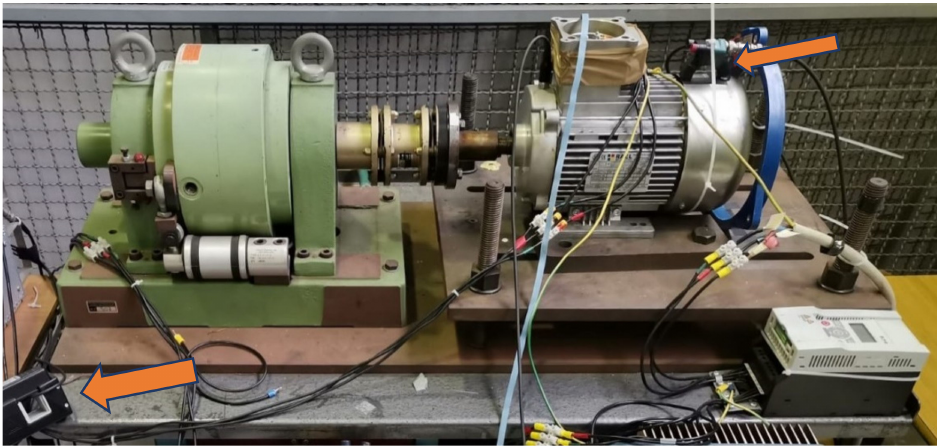
Figure 2. Laboratory test bed. Red arrows indicate the radial stray flux sensor and part of the current